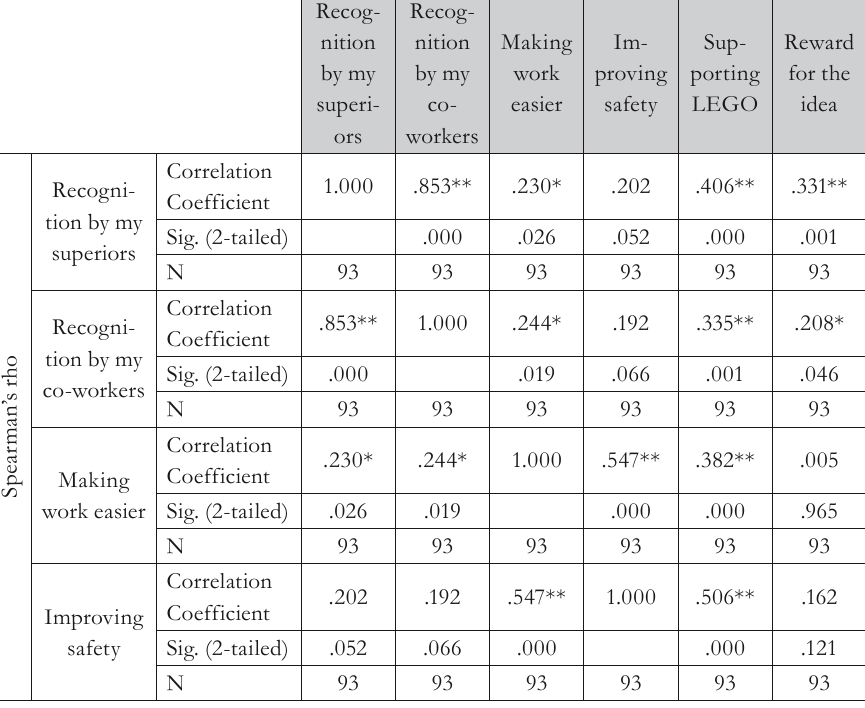
Tab. 3 - Factors motivating workers to submit ideas in the order of importance. Source: Au- thor’s Own